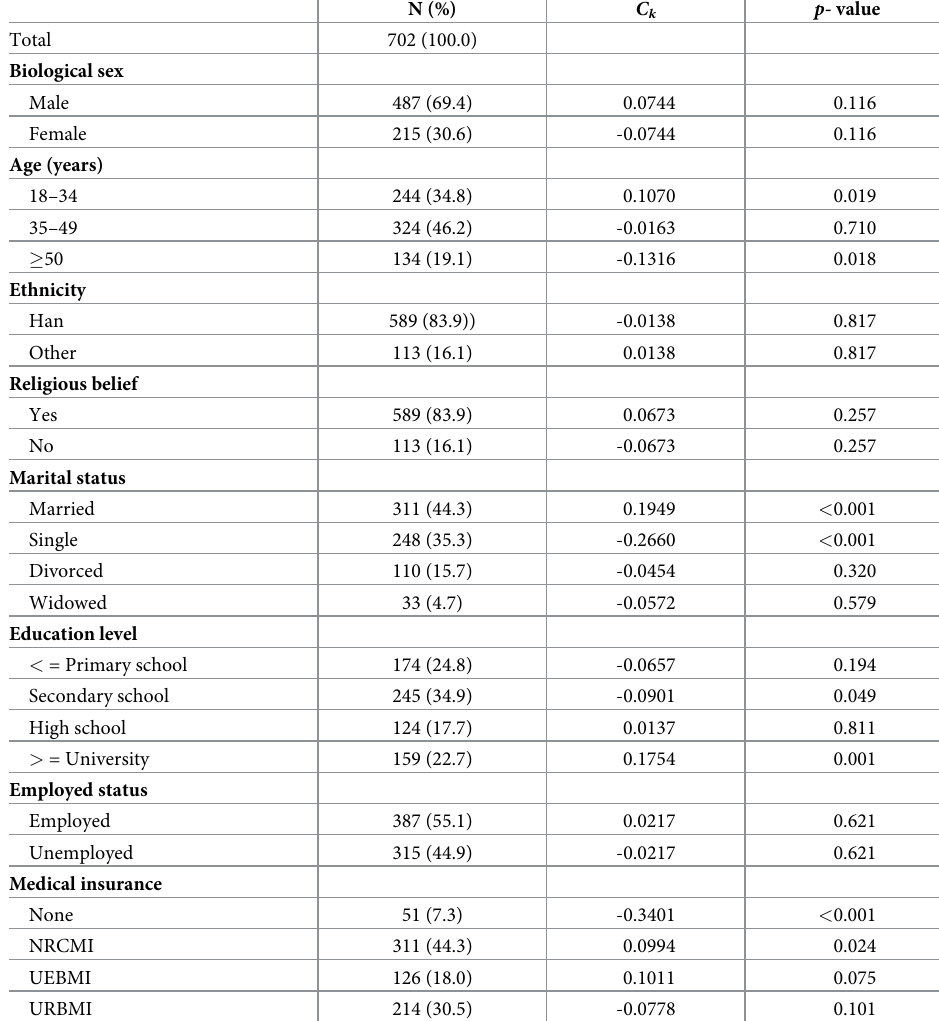
Table 1. Distribution and concentration indices of socio-demographic